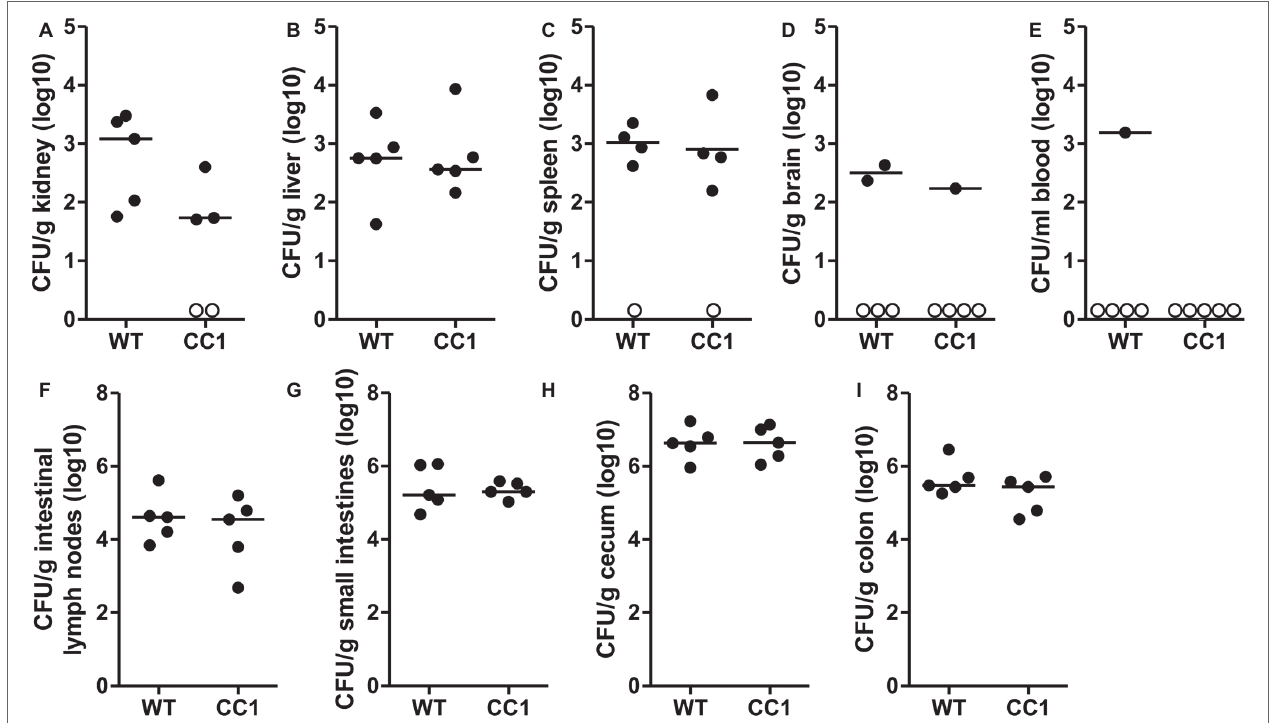
FIGURE 4 | The expression of human CEACAM1 does not influence the cyclophosphamide-induced systemic dissemination of C. albicans in a colonization model. Human CEACAM1-transgenic mice (CC1, N = 5) and their wild-type littermates (WT, N = 5) were treated with antibiotics from day − 4, inoculated with 5 × 10 7 CFU C. albicans orally at day 0 and injected with cyclophosphamide at day 11 (see also Table 1 ). On day 14, mice were sacrificed. Kidneys (A) , liver (B) , spleen (C) , brain (D) , and intestinal lymph nodes (F) were homogenized directly; small intestines (G) , cecum (H) , and colon (I) were cleared of their contents by rinsing before homogenization (see Figure 2 for the analysis of their contents). Homogenates were analyzed for their CFU content by plating dilutions on YPD/chloramphenicol agar. Blood (E) was plated without any homogenization step. Graphs show CFU/g tissue (log10) with median. Numbers of samples without any fungal burden are indicated below the respective groups. Statistical analysis was performed with logarithmized data by unpaired, two-sided Student’s t tests ( A : p = 0.064, B : p = 0.866, C : p = 0.849, D : p = 0.322, E : no t -test possible, F : p = 0.479, G : 0.829, H : p = 0.972, I : p = 0.186). All data are from one single